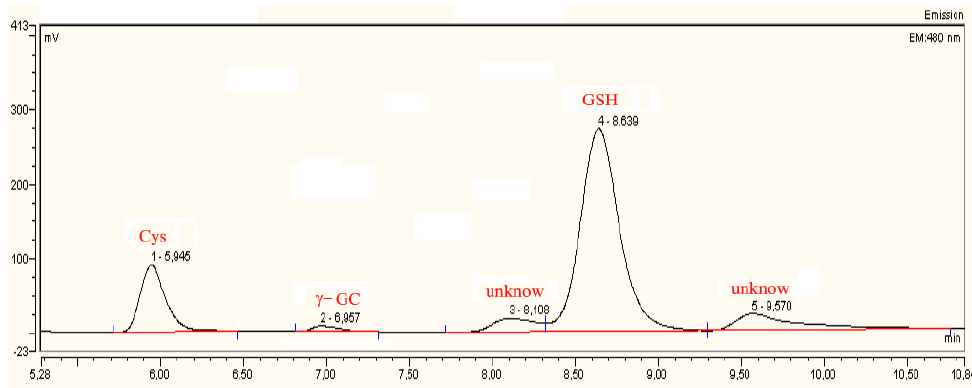
Figure 2. HPLC-FLD profile of Cys, γ -GC and GSH from acid extract of Brassica rapa L. separated using a discontinuous gradient of sodium acetate-methanol on Beckman UltraSphere C-18 ODS reverse-phase column. Excitation wavelength 392 nm; detection wavelength 480 nm.